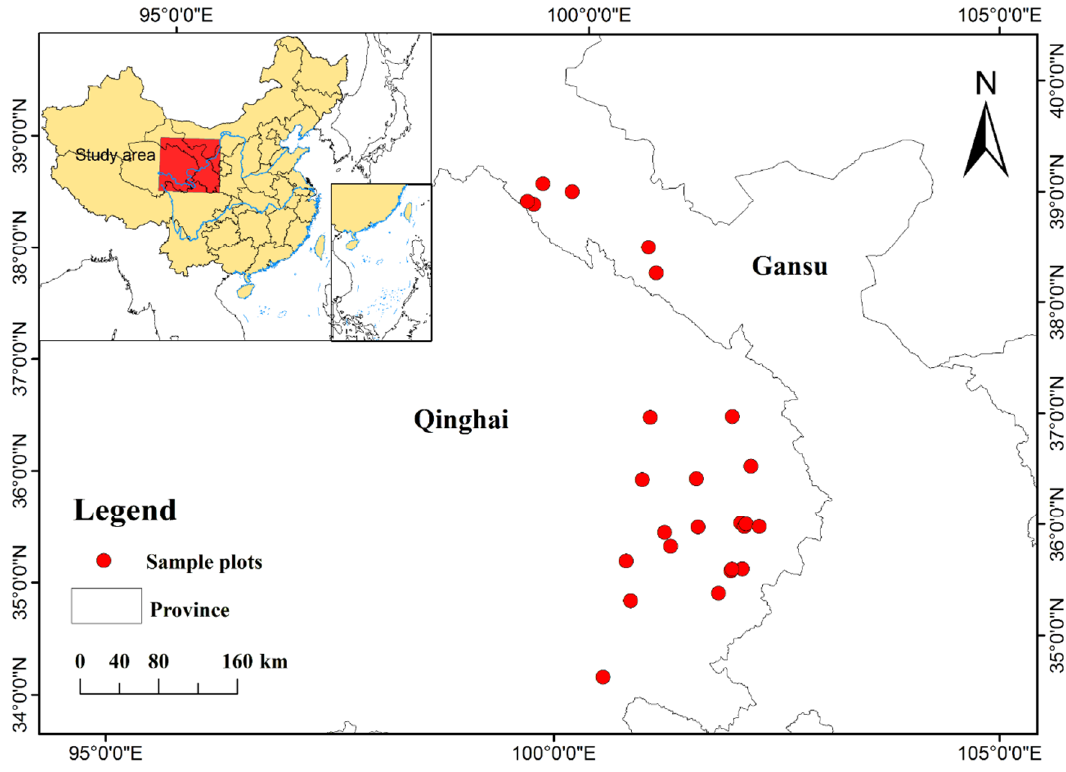
Figure 1. Geographic distribution of the sampling sites ( n = 25) in Qinghai and Gansu Provinces.